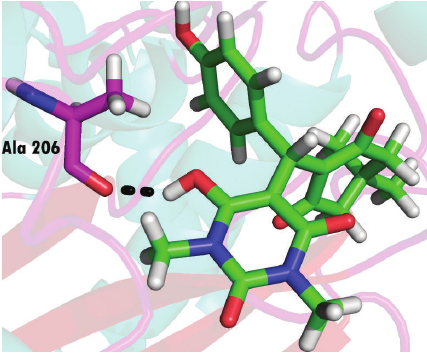
Figure 5: Three-dimensional representation of compound 4v with target macromolecule thymidine